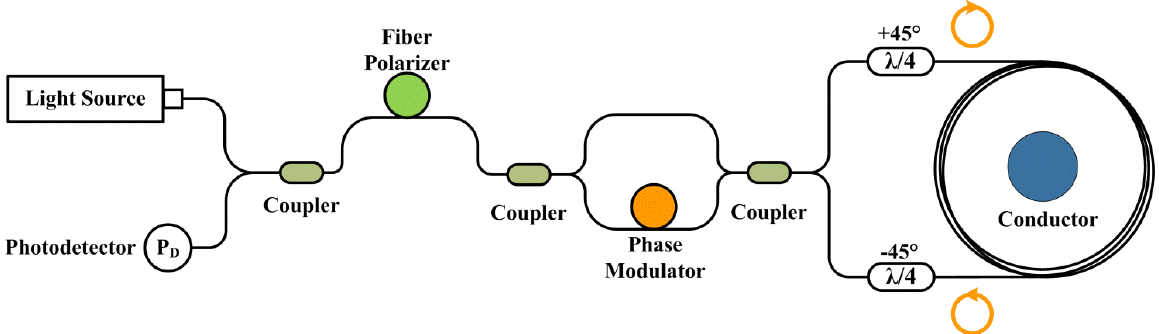
Figure 5. Sagnac loop interferometer current